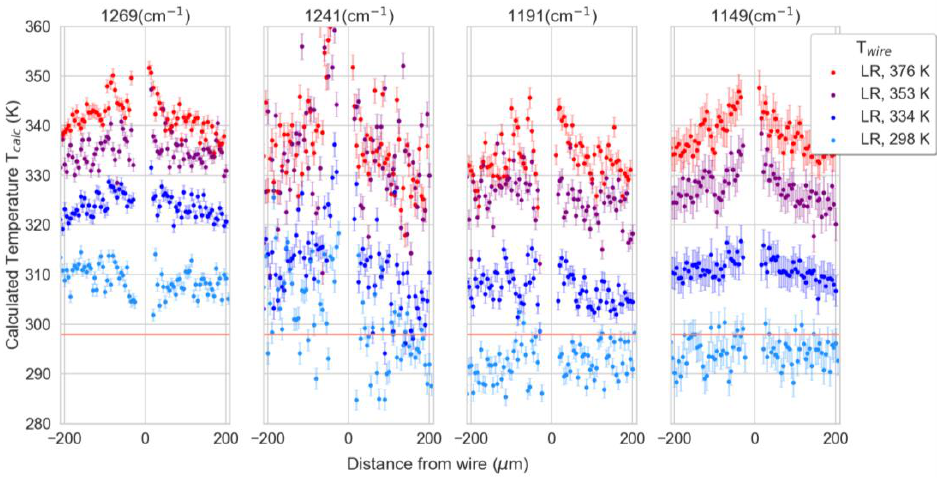
Figure 4. Calculated sample temperatures (T calc ) at +/ − 200 µm from the heating wire (x = 0), using the peaks at 1269, 1241, 1191, and 1149 cm −1 , including error bars. For each measurement, the wire temperature (T wire ) was left at room temperature (298 K, light blue) or heated to 334 K (blue), 353 K (purple), or 376 K (red). Prior to each measurement, the wire temperature was given at least 10 min to equilibrate. The room temperature inside of the cryostat is indicated with horizontal red